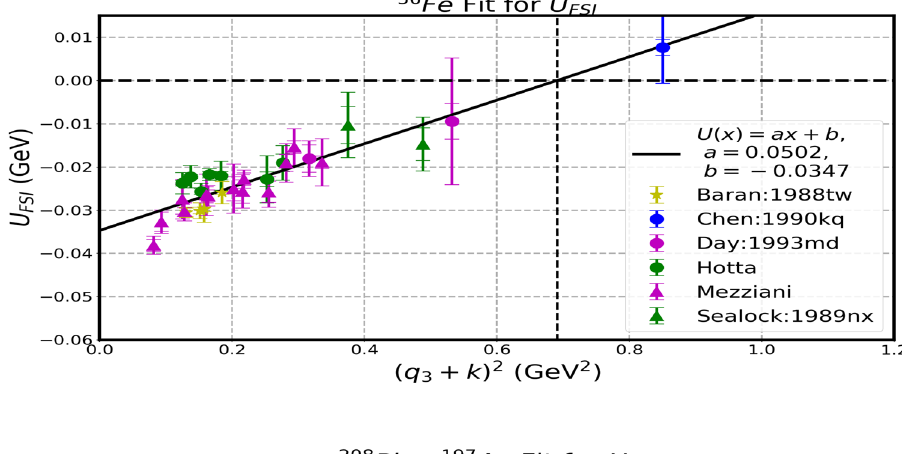
Fig. 21 Extracted values of U FSI versus ( q 3 + k ) 2 for 22 Lead ( 208 Pb) and one Gold 82 ( 197 Au) spectra 79